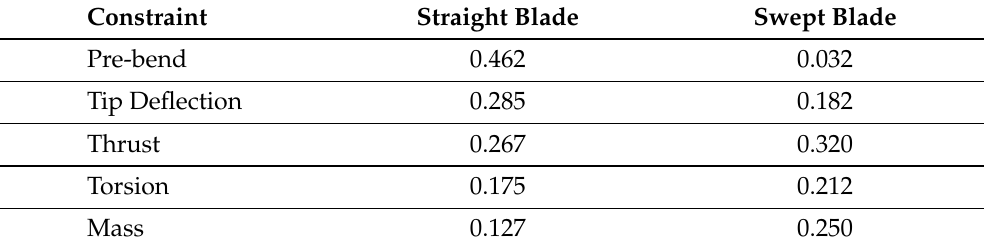
Table 1. The Effect of Constraints on Blade Length.